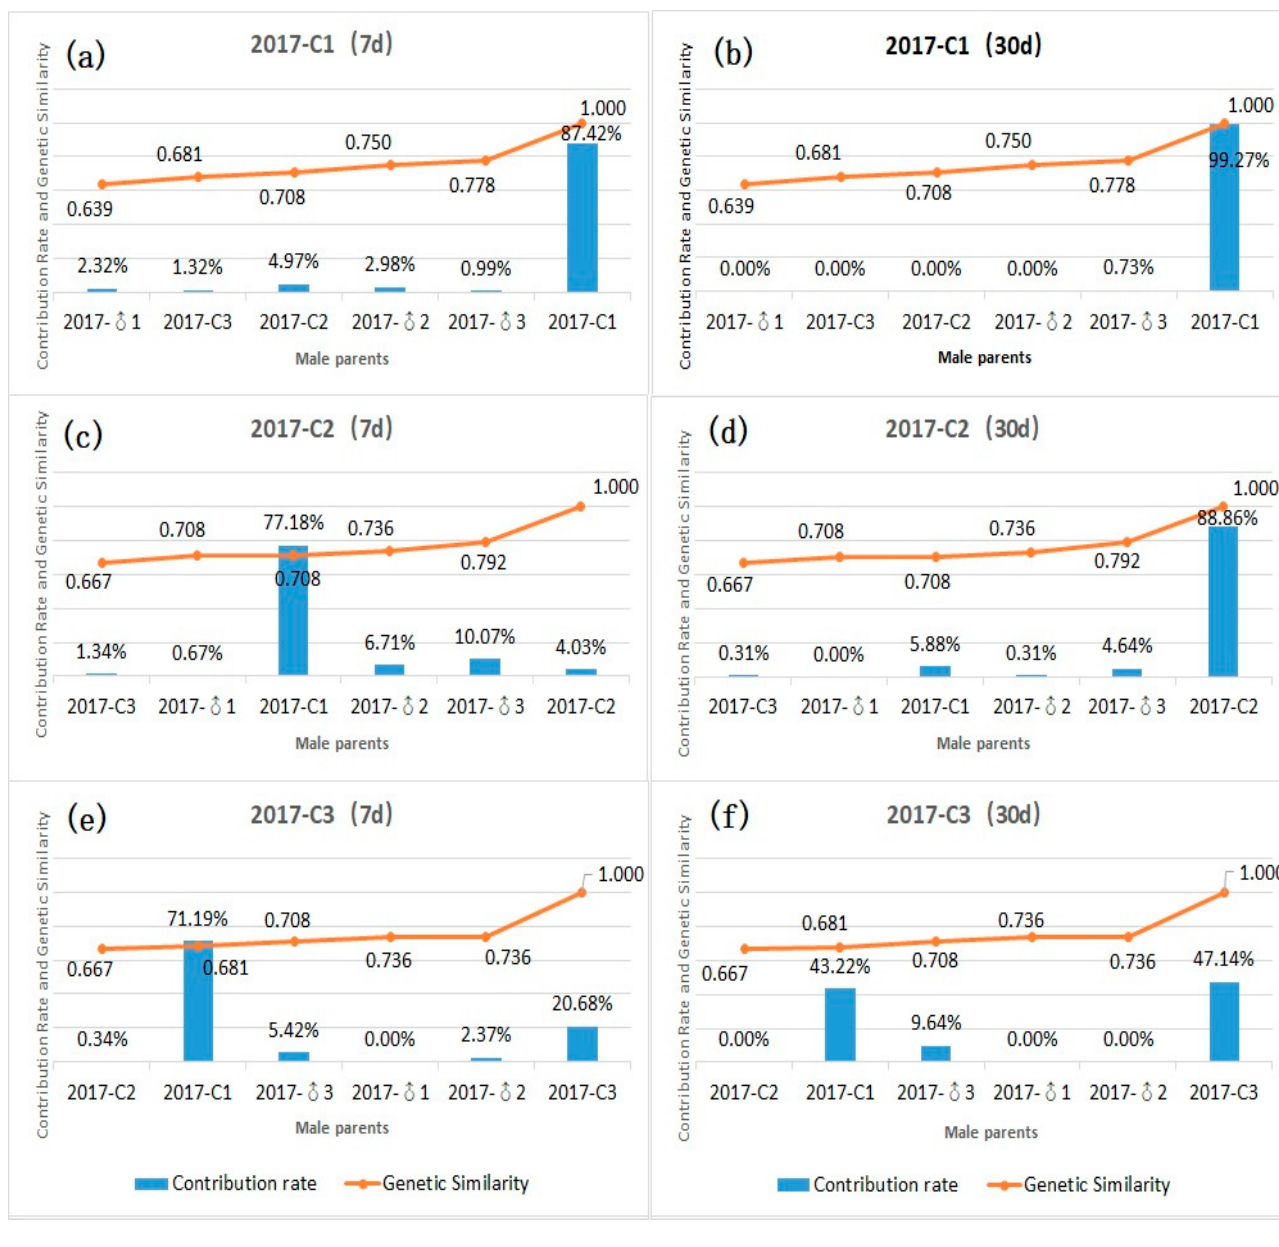
Figure 8. Contribution rate of each male parent and genetic similarity between each male parent and the female parent for the hybrid combinations: ( a ) ♀ 2017-C1, ( c ) ♀ 2017-C2, and ( e ) ♀ 2017-C3 at 7 days after pollination, and ( b ) ♀ 2017-C1, ( d ) ♀ 2017-C2, and ( f ) ♀ 2017-C3 at 30 days after pollination.